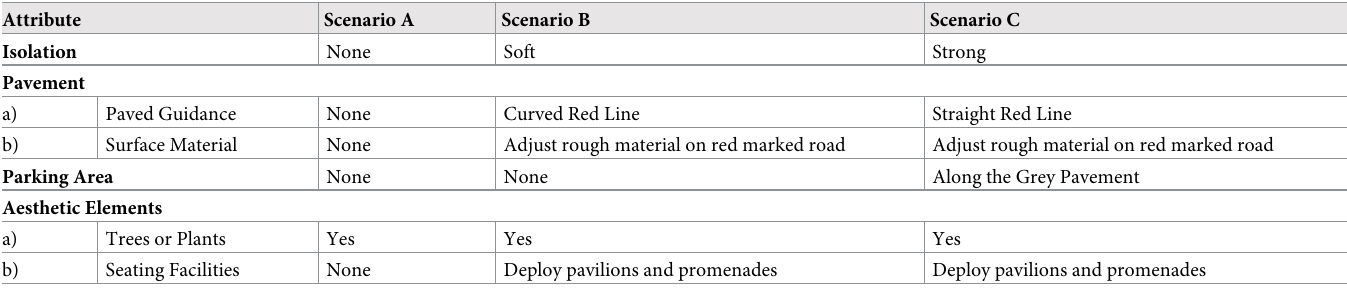
Table 1. The attributes classification of scenario